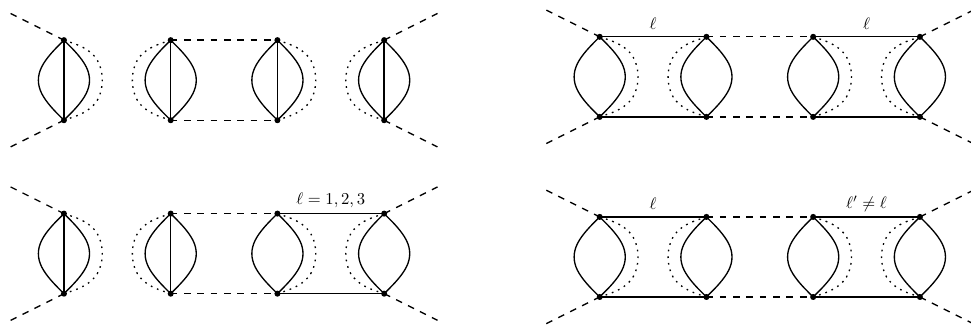
Figure 7 . Leading order graphs renormalizing the couplings ~ (cid:21) p (top right) and ~ (cid:21) (all the others).